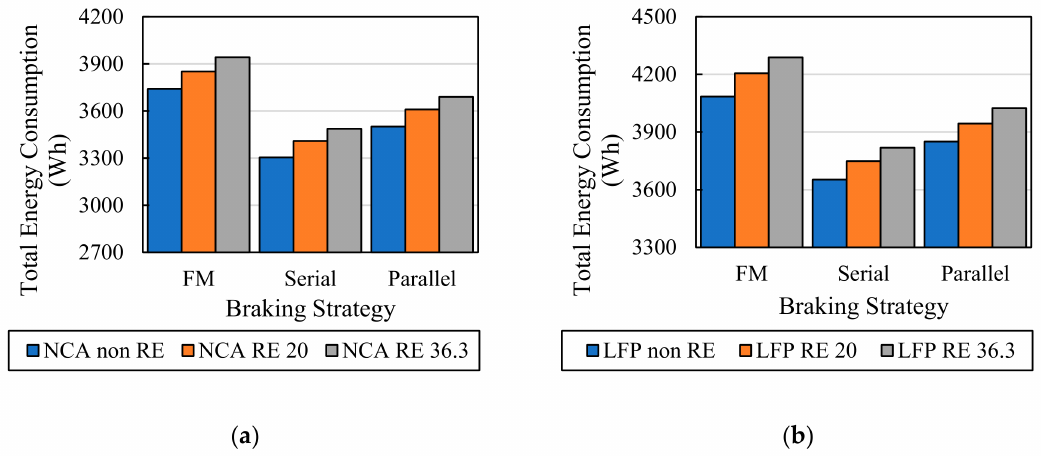
Figure 14. Total energy consumption for the ( a ) NCA and ( b ) LFP battery for the first